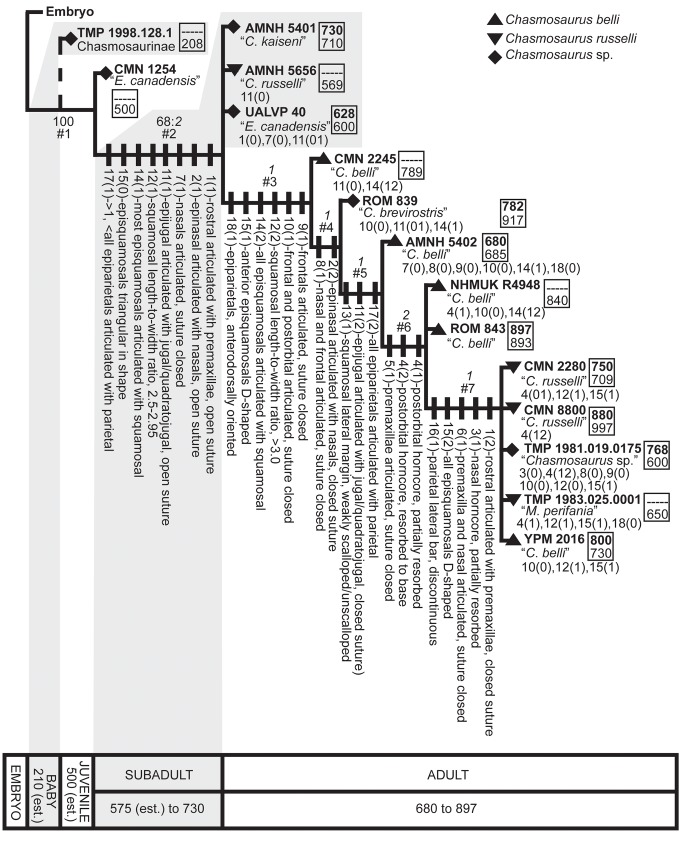
Ontogenetic transformation series for Chasmosaurus specimens.Strict consensus of 24 most parsimonious trees (TL = 40 steps, CI = 0.65, RI = 0.81) using 18 cranial characters. Bootstrap replicate frequency is shown above each node (only Bootstrap values of 50% or higher are given); Bremer values are shown above each node, in italics. Characters and associated states (shown in brackets) are shown on left and are mapped at their earliest occurence on the tree. These character state changes represent an inferred sequence of development; however, due to variable timing of character changes amongst specimens, this sequence is an approximation. Below each specimen is the previous taxonomic designation; state reversals are listed below. In box to the right of each specimen, rostral-to-epijugal length (top, bold, in mm; parameter 16, Fig 2) and squamosal length (bottom, in mm; parameter 19, Fig 2) are given for skull size reference, where preserved. Although TMP 1998.128.0001 was not included in the analysis, its basal position on the tree is indicated by a dashed line, inferred based on its small size and possession of immature character states (12(0), 13(0), and 14(0)). Boxes at bottom delimit age classes (see text for definitions); numbers below each box represent rostral-to-epijugal lengths (in mm) for each age class (est. = estimated). [planned for page width].